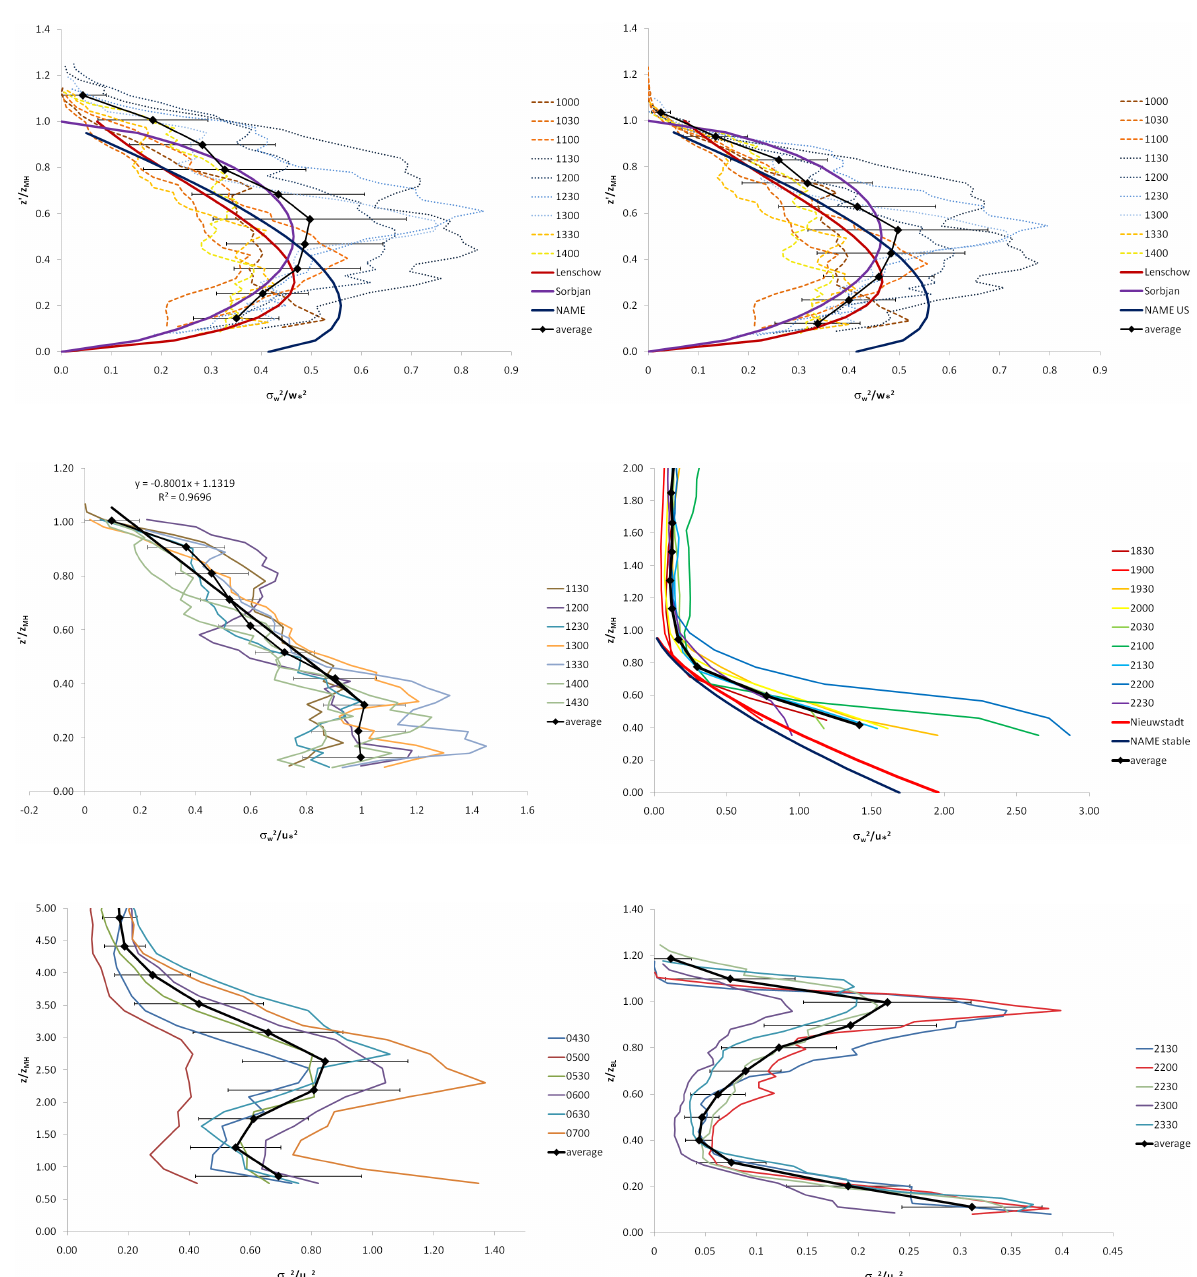
Fig. 6. Scaled profiles of vertical windspeed variance. (a) convective conditions. (b) convective conditions with rescaled height axis. (c) near neutral conditions with rescaled height axis. (d) stable conditions with rescaled height axis. (e) possible nocturnal jet profile. (f) cloud-topped night-time